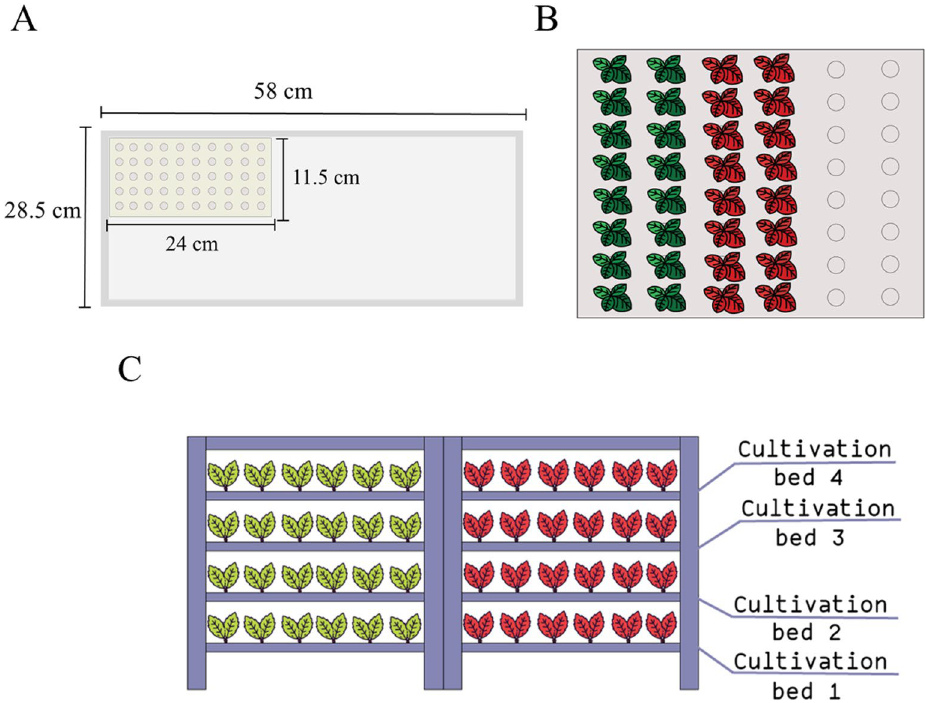
Figure 1. Top view of the sponge 50-cell germination ( A ), top view hydroponic foam board for early plant growth of holy basil ( B ) and side view of cultivation bed (4 cultivation beds) under fully control environment in the PFAL